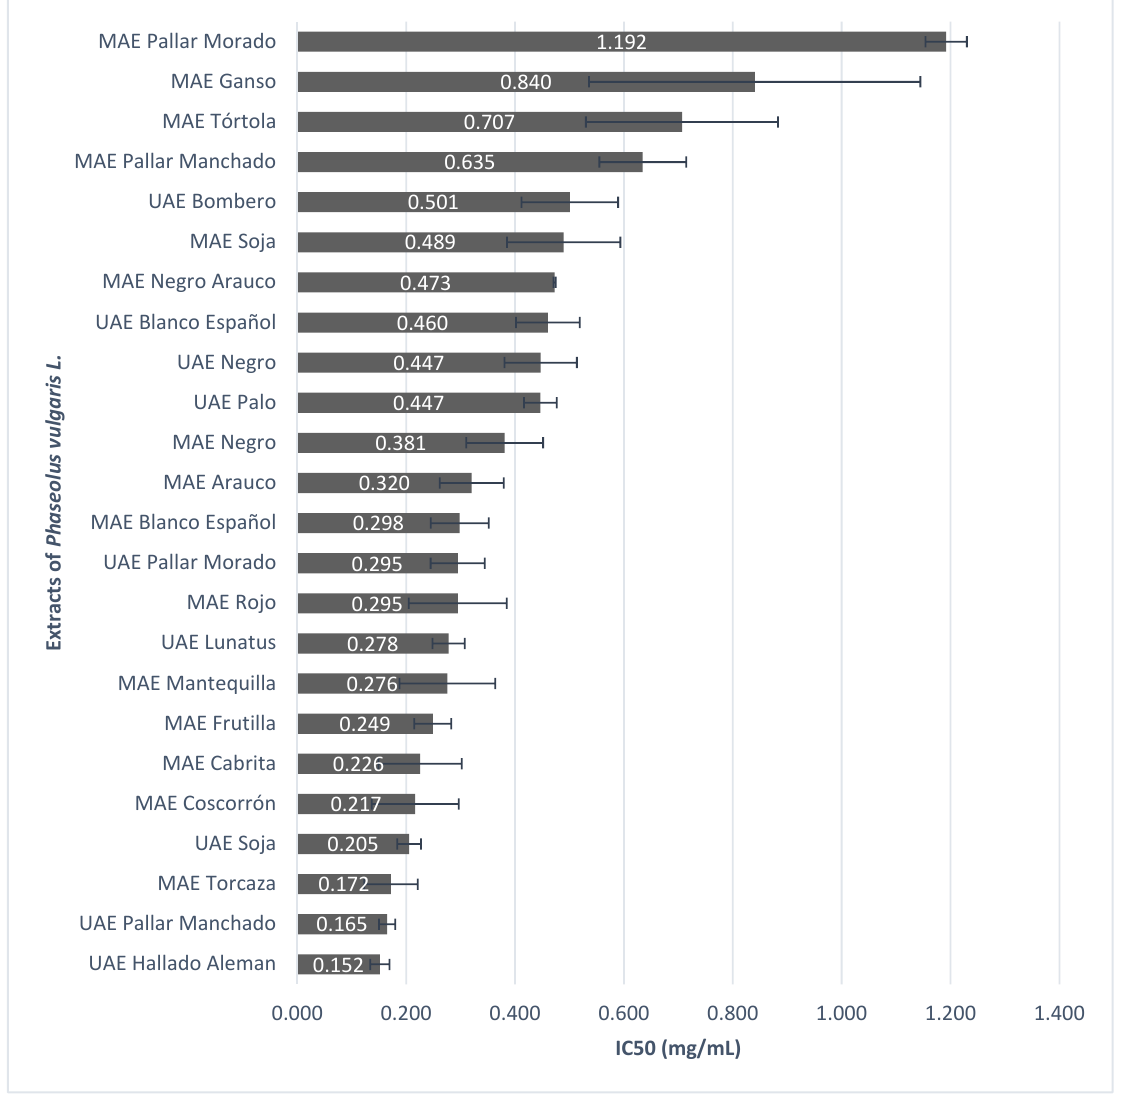
Figure 2. Platelet inhibition of more active extracts of P. vulgaris L. The more active extracts, with the percentage of platelet inhibition above 50%, were selected to evaluate the concentration necessary to reduce platelet aggregation by 50% (IC 50 ), determined from the concentration curves of the extracts of common bean at 0.025, 0.05, 0.10, 0.25, 0.50, 0.75 and 1.00 mg/mL.